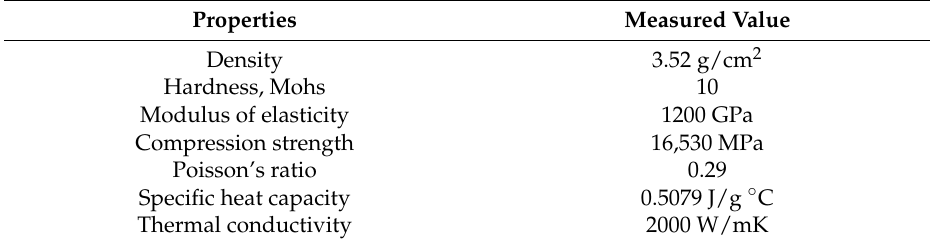
Table 3. The properties of natural diamond.